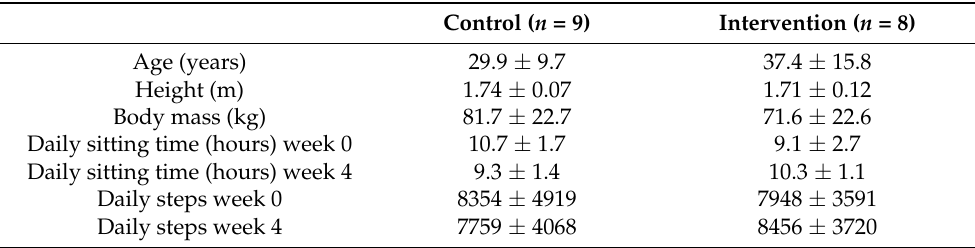
Table 1. Participant physical and sedentary behaviour characteristics. Values are means ±